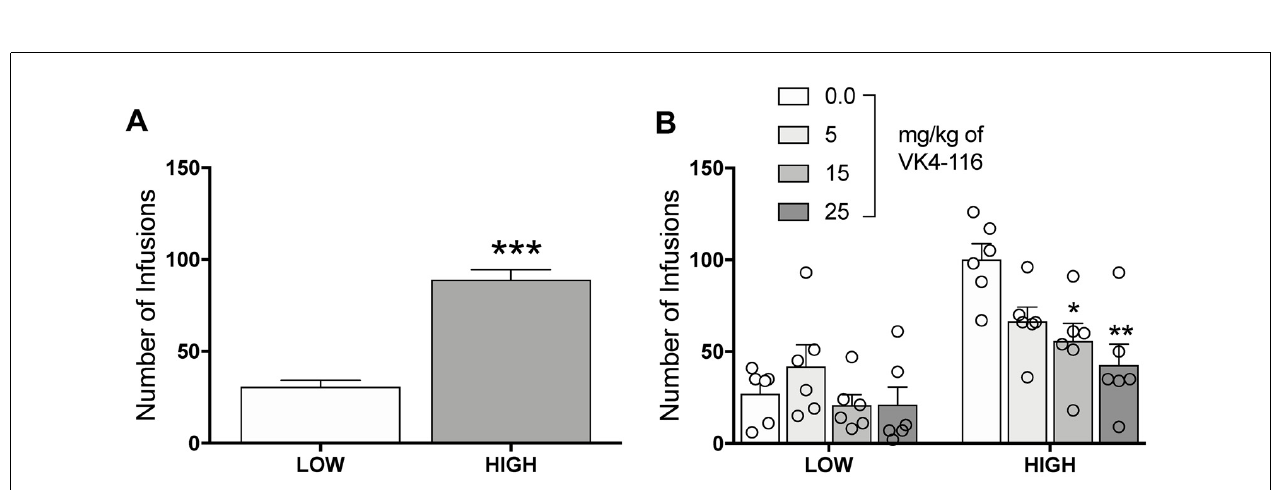
FIGURE 3 | (A) Oxycodone self-administration in HS rats with high vs. low intake. ∗∗∗ p < 0.001. (B) Effect of VK4116 in HS rats with high vs. low oxycodone intake. ∗ p < 0.05, ∗∗ p < 0.01, vs. 0 mg/kg.